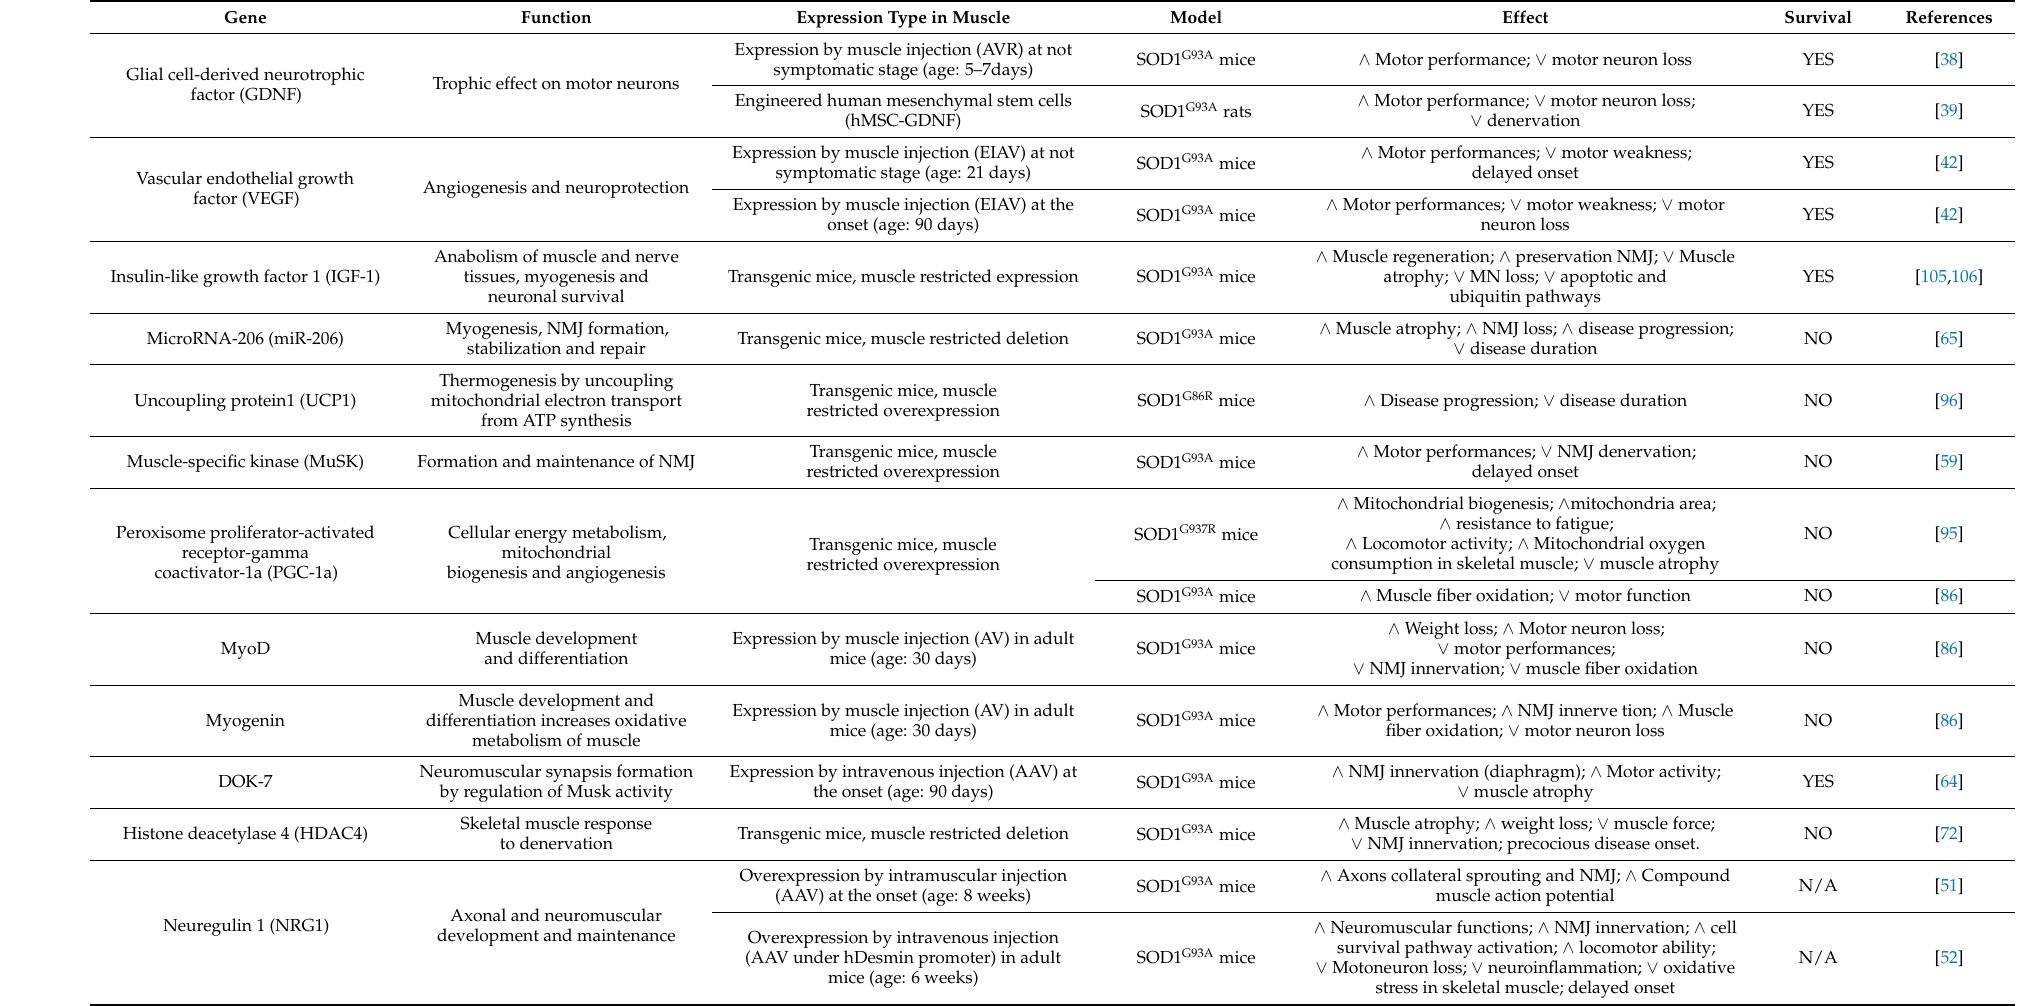
Table 1. Genetic